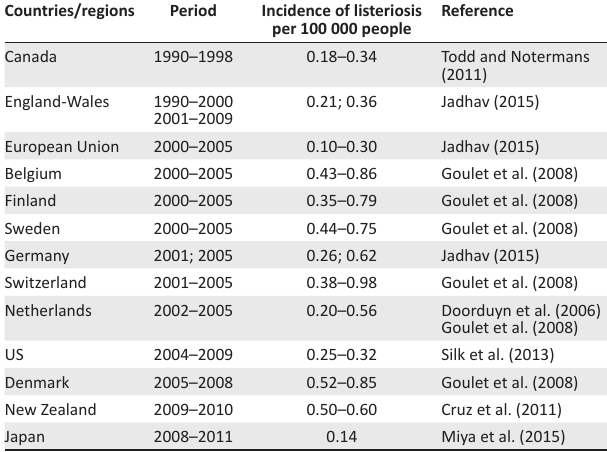
TABLE 2: Incidences of listeriosis in different countries.